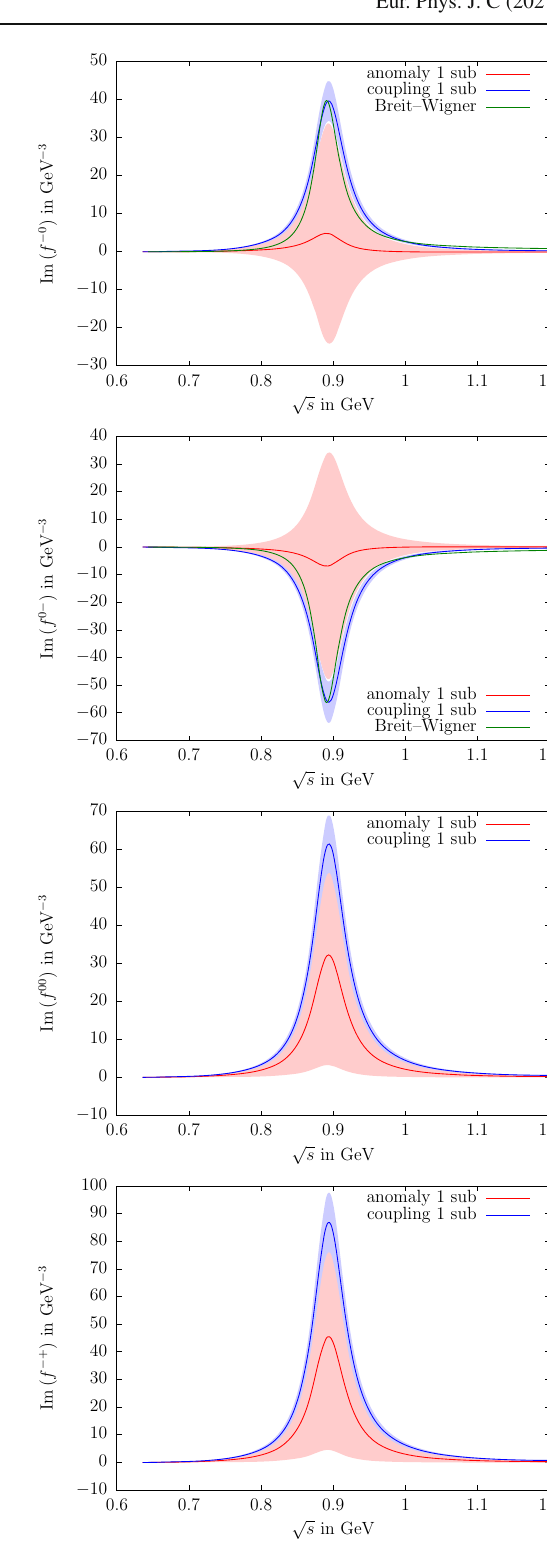
imaginary parts of the partial waves, respectively. For comparison a Breit–Wigner model [44] is also shown. The error bands refer to the uncertainties on the subtraction constants and the t -channel